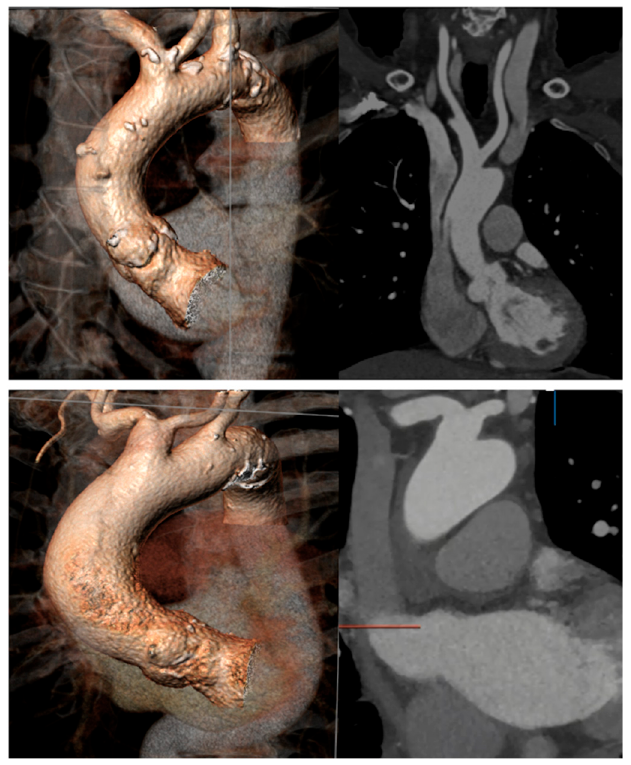
Figure 2. Two examples of bovine aortic arch anatomy suitable for Sentinel insertion. Table 1. Baseline clinical and aortic valve characteristics in patients undergoing transcatheter aortic valve replacement (TAVR) with concomitant cerebral protection.